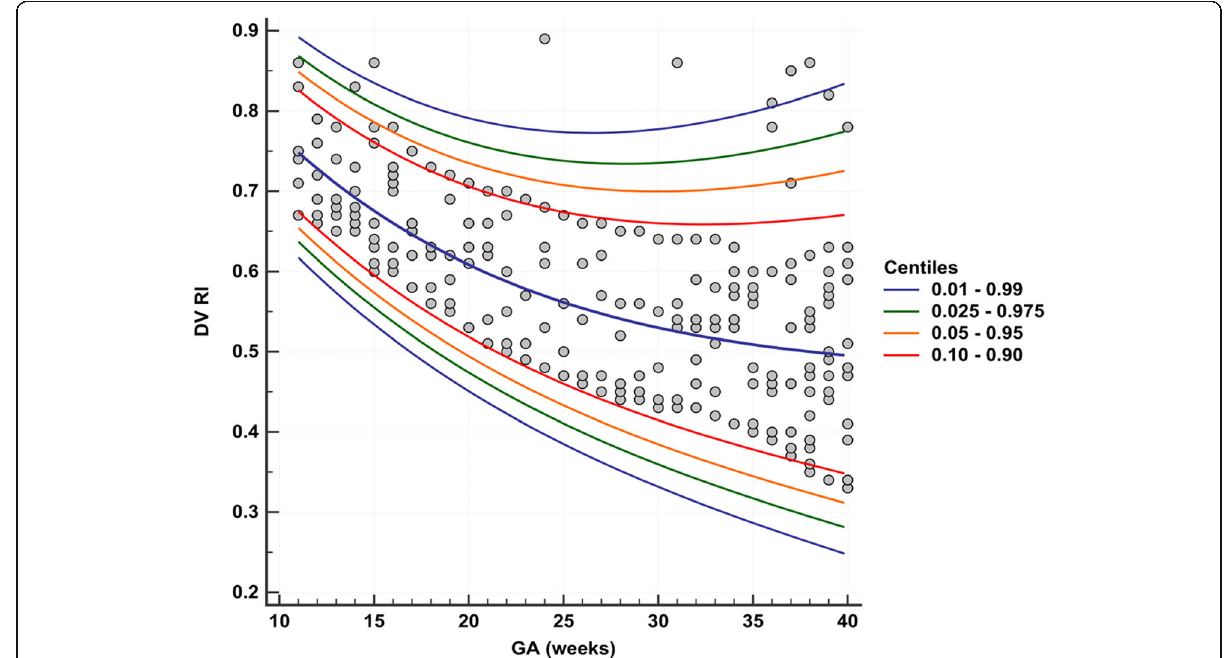
Fig. 5 Scattered diagram of gestational age individual measurement and calculated reference ranges for DV RI in normal pregnancies (690 observations) with 1th – 99th percentiles (blue